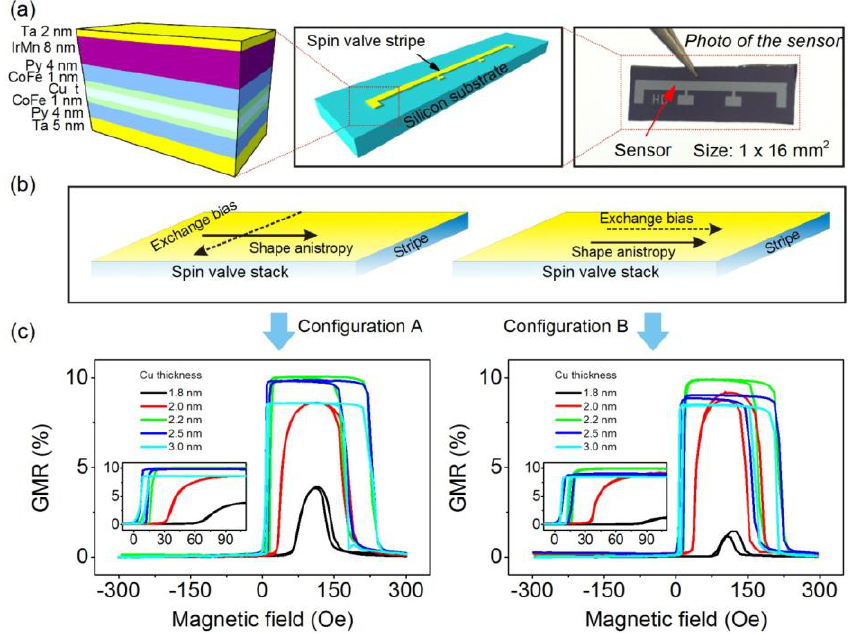
Figure 1. ( a ) Schematic representation of the layer stack of spin valve sensors (left) and a sensor stripe on a silicon substrate (middle), as well as the photograph of a spin valve sensor patterned with a size of 1 × 16 mm 2 (right); ( b ) Schematics of two anisotropy configurations of spin valve sensors, which are achieved by setting the direction of exchange bias with respect to shape anisotropy. For Configuration A (crossed anisotropy), the exchange bias is along the short axis of the sensor stripe, and hence, it is perpendicular to the direction of the shape anisotropy. For Configuration B (parallel anisotropy), it is along the long axis of the sensor stripe parallel to the direction of the shape anisotropy; ( c ) Giant magnetoresistive (GMR) curves for the spin valve sensors prepared with crossed and parallel anisotropy configurations. The spin valve sensors are of the same layer stack structure as shown in (a) and the thickness of Cu ranges from 1.8 nm to 3.0 nm. Inset: The GMR response of the free layer. The x- and y-axis correspond to those in the main figure.